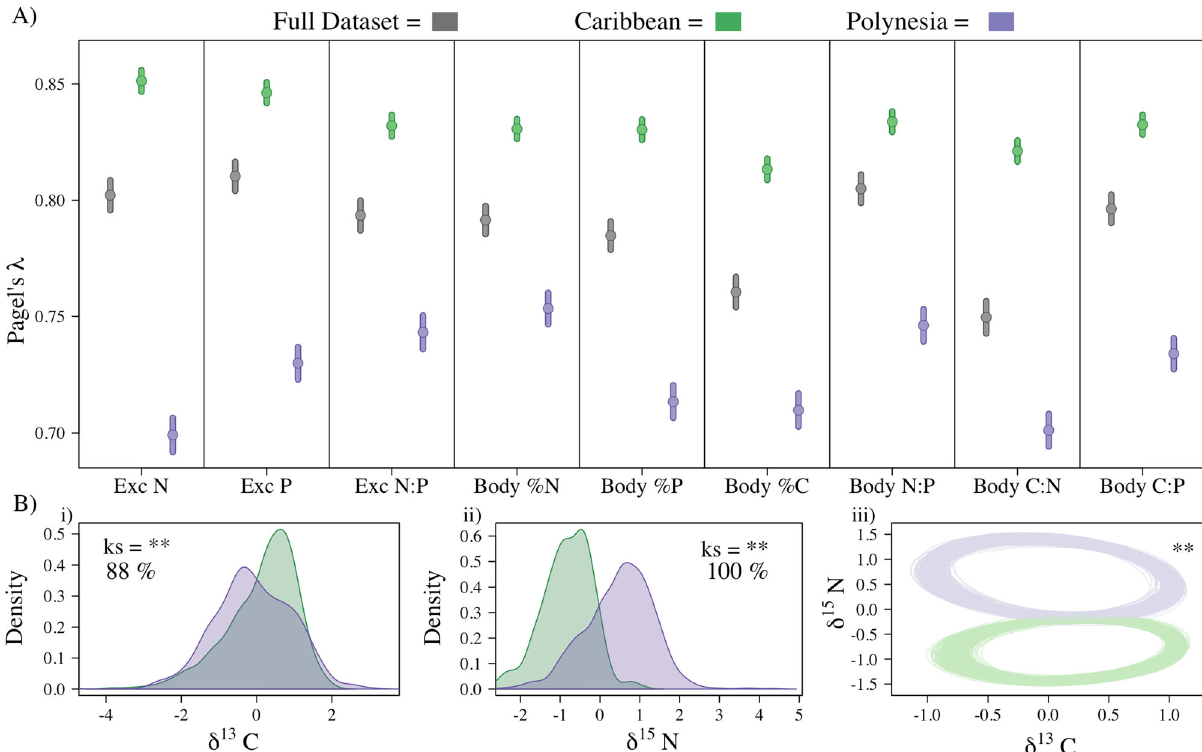
Fig. 2 The larger phylogenetic signal for all traits is consistent with a more constrained dietary niche in the Caribbean. A Relative phylogenetic signal for the two regions and the full dataset (gray) as quanti fi ed by Pagel ’ s Lambda ( λ ) using a bootstrapped analysis for each trait whereby the points represent the mean and error bars indicate SD of all bootstrapped iterations. In all cases, values signi fi cantly differ across regions and also between regions and the full dataset. B i – ii Comparisons of standardized δ 13 C and δ 15 N ( n = 499 and 829 for Caribbean and Polynesia, respectively for both δ 13 C and δ 15 N) distributions between two regions. “ ks ” indicates Kolmogorov – Smirnov tests for differences in the shape of the two distributions. “ ** ” indicates statistical signi fi cance at α = 0.05. Percentages indicate the percent of iteratively sampled communities in which statistical signi fi cance was con fi rmed. B iii Standard ellipse area estimated from standardized isotopic values generated from iterative resampling (without replacement) of individuals from the two regions. “ ** ” indicates that in all iteratively sampled communities ellipse areas were larger in Polynesia than the Caribbean — note the comparison of niche width is only for relative size, not location of the ellipse. The convex hull was also estimated for each sampled community and for all iteratively sampled communities the convex hull was larger in Polynesia than in the